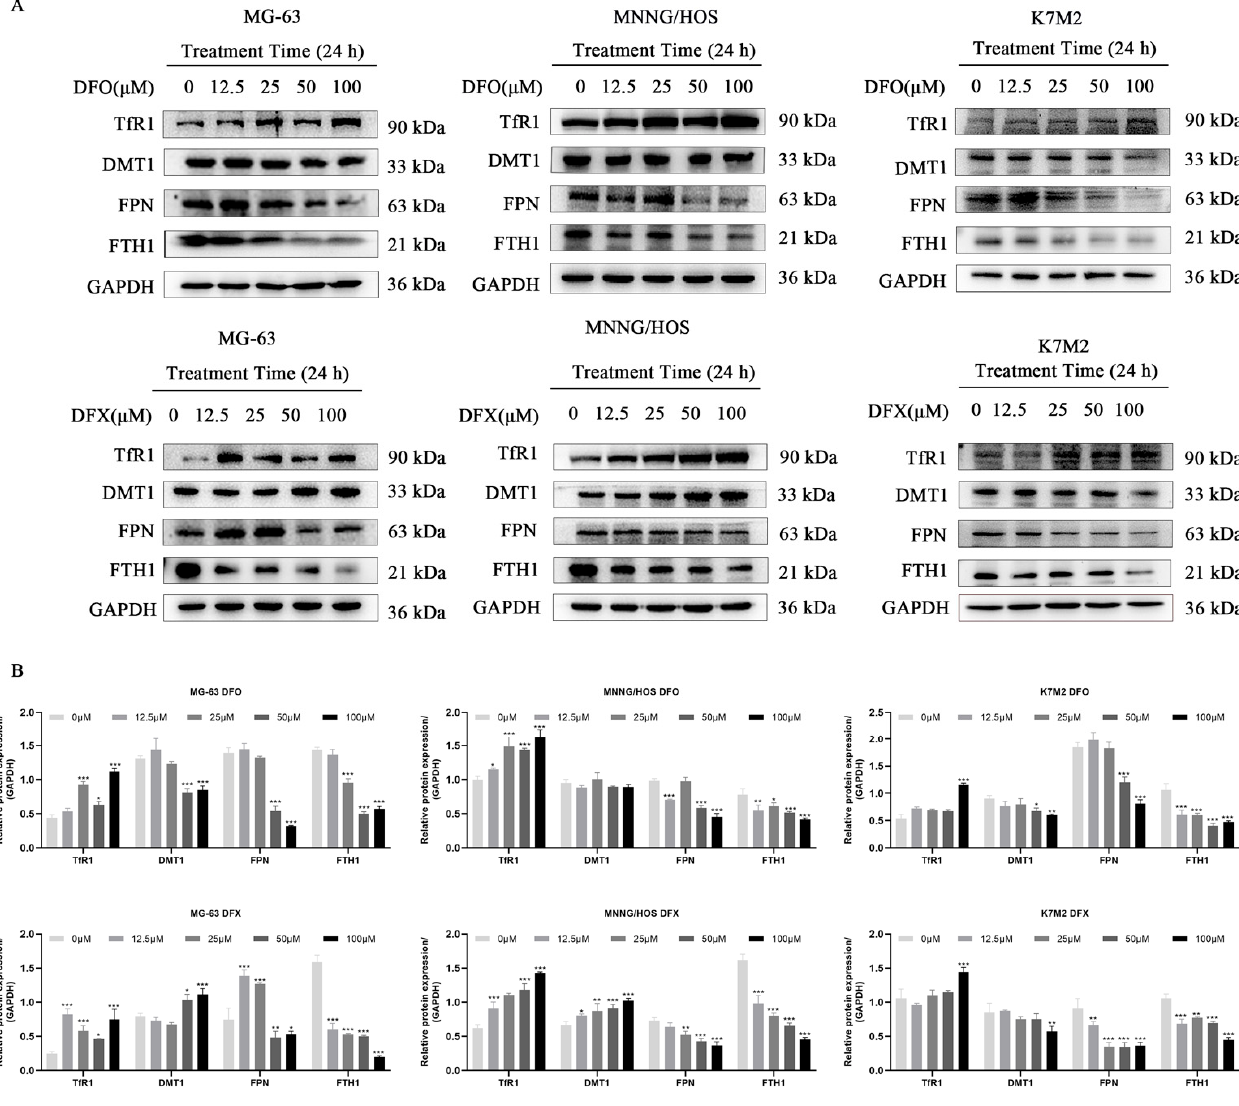
Figure 3. Iron chelators altered iron metabolism in osteosarcoma cells. ( A ) Protein expression levels of TfR1, DMT1, FTH1 and FPN in MG-63, MNNG/HOS and K7M2 cells treated with the indicated concentrations of DFO and DFX for 24 h. ( B ) Quantitative analysis of TfR1, DMT1, FPN and FTH1 in MG-63, MNNG/HOS and K7M2 cells treated with the indicated concentrations of DFO and DFX for 24 h. * p < 0.05, ** p < 0.01 and *** p < 0.001 versus control group.